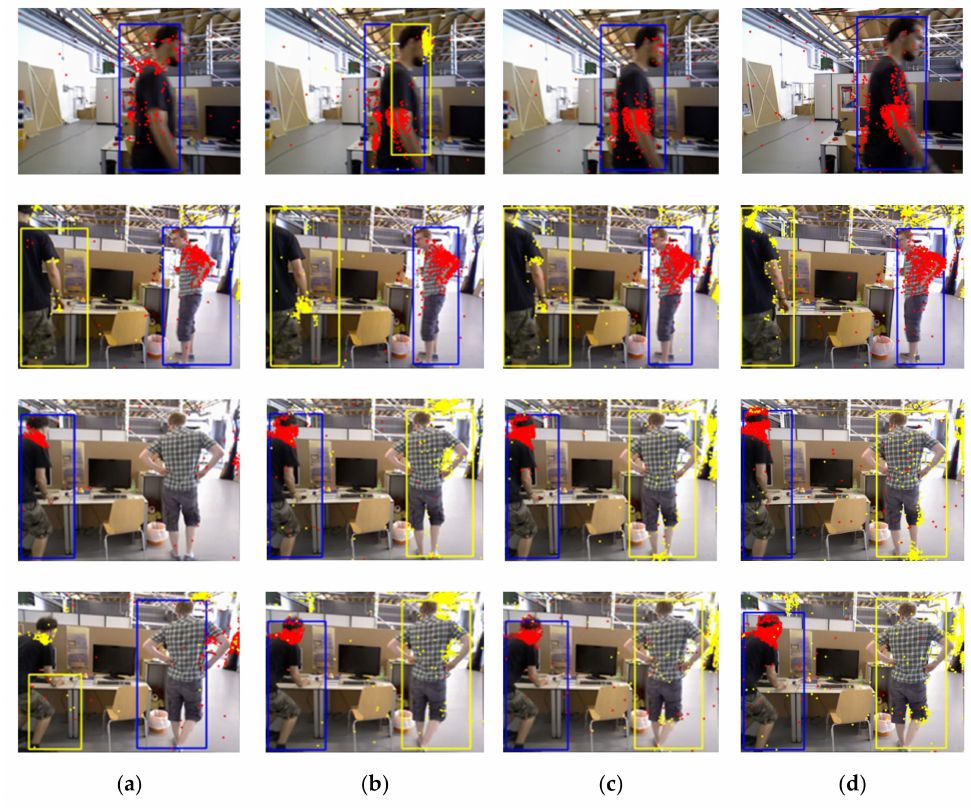
Figure 9. The comparison of tracking and segmentation examples with different numbers of particle points. ( a ) 500 particles; ( b ) 800 particles; ( c ) 1000 particles; ( d ) 1200